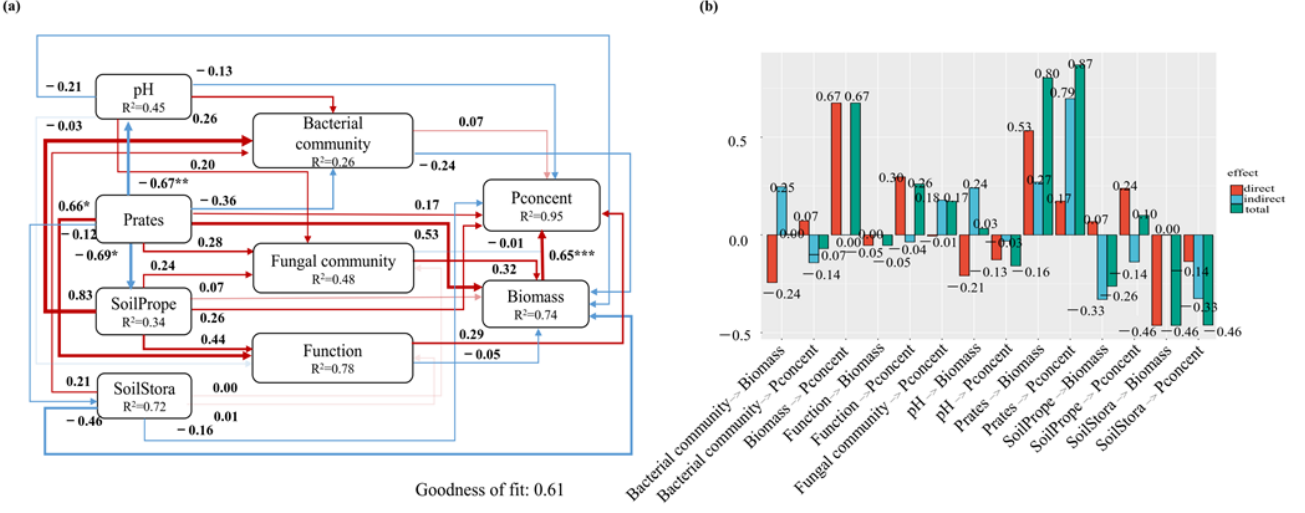
Figure 5. The relationships between rate of P fertilizer application (Prate), soil properties (SoilPrope), soil pH, soil stoichiometric ratio (SoilStora), soil bacterial and fungal community (data of PCoA axis1), function (PCoA axis 1 of KEGG pathways and number of arbuscular mycorrhizas), plant biomass and P content ( a ). Path model outputs: the numbers on arrows represented standardized path coefficients. The arrow width indicated the value of each path coefficient; the red and blue lines indicated positive and negative effects, respectively. Standardized path coefficients on biomass and P concent ( b ). * represents p < 0.05, ** represents p < 0.01 and *** represents p < 0.001.